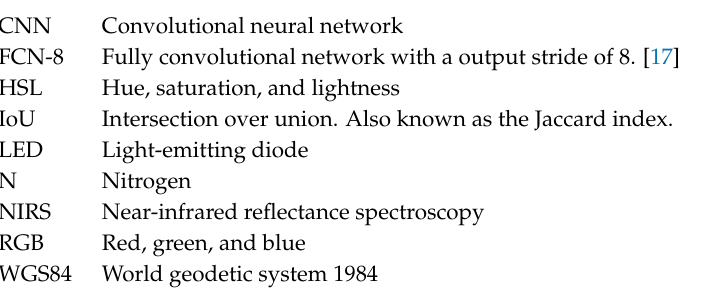
Figure 1: Example of the image analysis on a real image. Each element in the image is analyzed and classified as either grass (blue), clover (red), weeds (yellow) or unidentified (black overlay). (a) Example input image. (b) Automatically analyzed